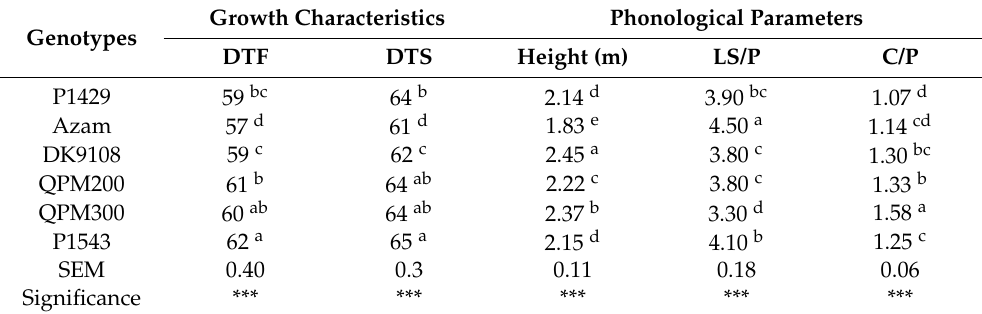
Table 1. Growth and phonological characteristics of spring maize genotypes evaluated for silage production.